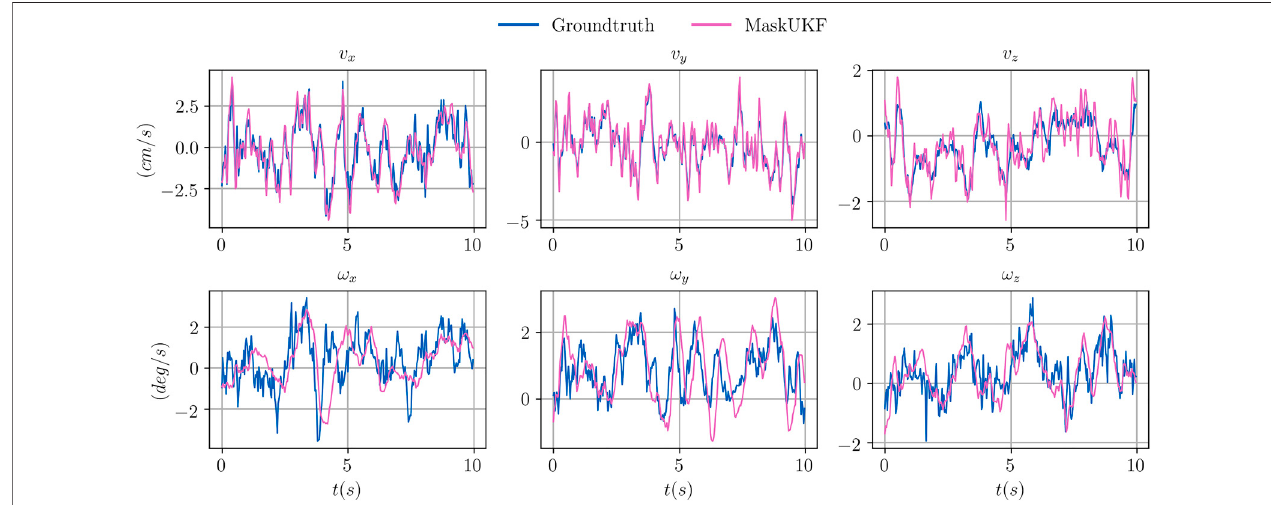
FIGURE 4 | Comparison between estimated linear ( v ) and angular ( ω ) velocities for several algorithms within a video sequence from the YCB Video dataset. The ground truth velocities are obtained from fi nite differences.